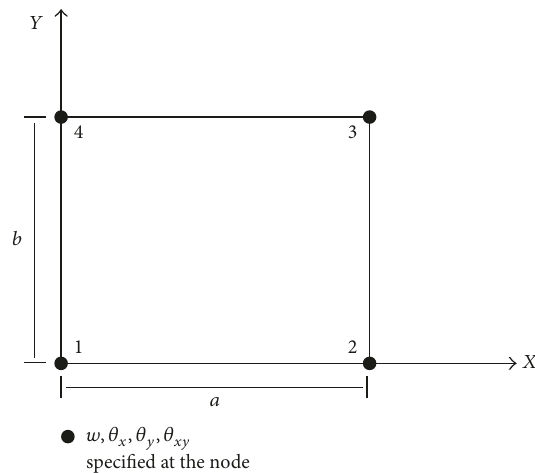
Figure 1: Conforming four-node rectangular elements with 16–DOF ensuring 𝐶 1